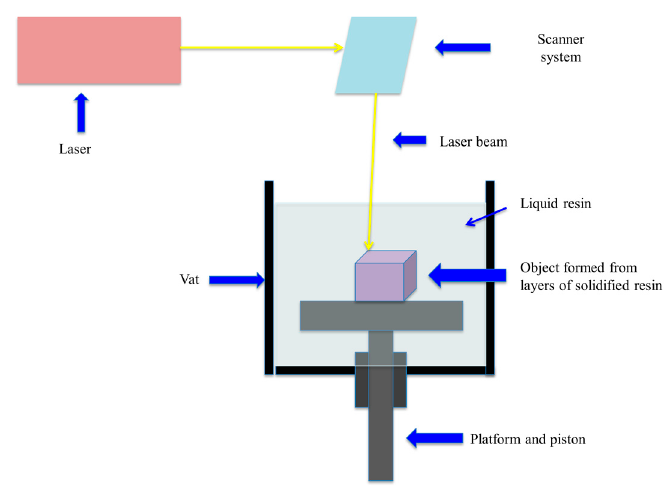
Figure 4. Stereolithography (SLA) printer.